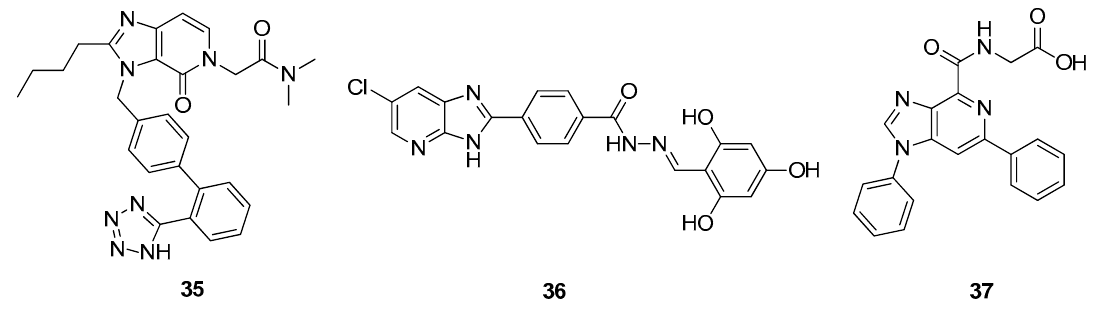
Figure 12. Imidazo[4,5- b ]pyridine and imidazo[4,5- c ]pyridine derivatives with a variety of activities.